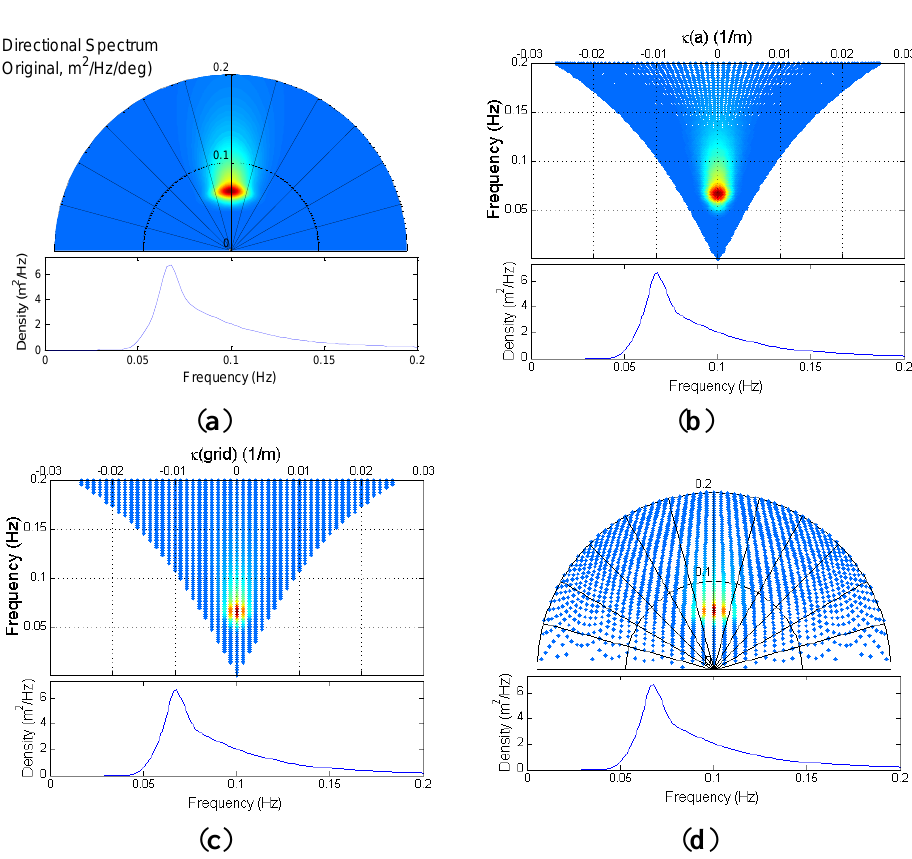
Figure 5. Illustration of the mapping of the directional JONSWAP spectrum from the (f,θ) space onto the (f,κ) space, and back for the shore-perpendicular spectrum. Upper panels: directional spectra in different representations; lower panels: corresponding frequency spectrum. The transformation preserves the frequency spectrum. ( a ) Standard (f,θ) representation of the JONSWAP directional spectrum at 15 m isobaths; ( b ) Direct map from (f,θ) to (f,κ) . The resulting grid in κ is not uniform; ( c ) Spectrum re-sampled in the uniform κ grid used for computation; ( d ) Spectrum directly mapped back to (f,θ) space. The angle grid is not uniform. Units of the variance density contour plots are